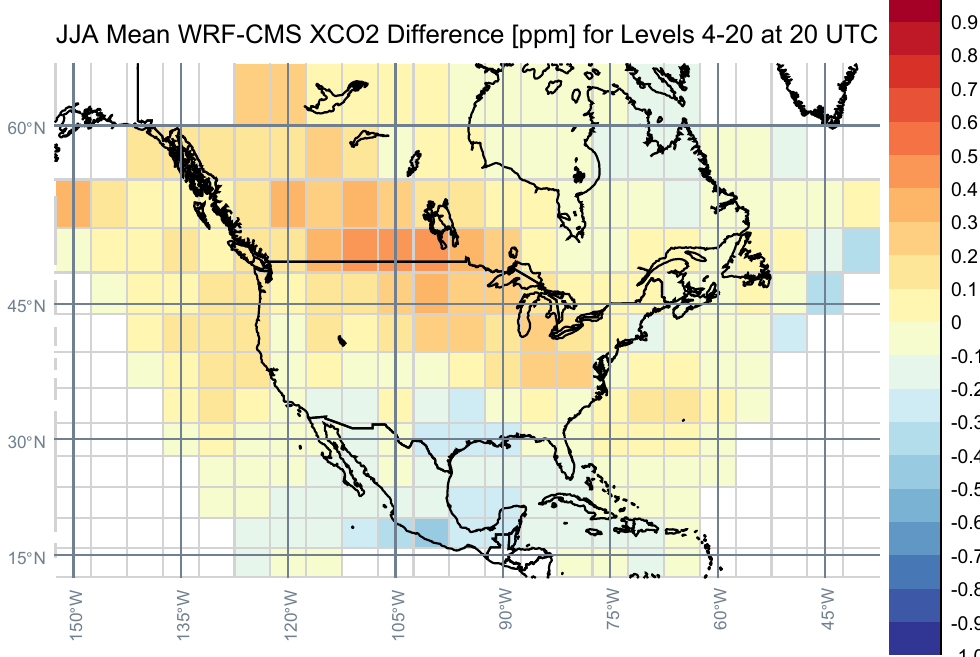
Figure A5. Model-model differences in the upper column (above ∼ 850 hPa). compare these results to Figure 6b in the main text.